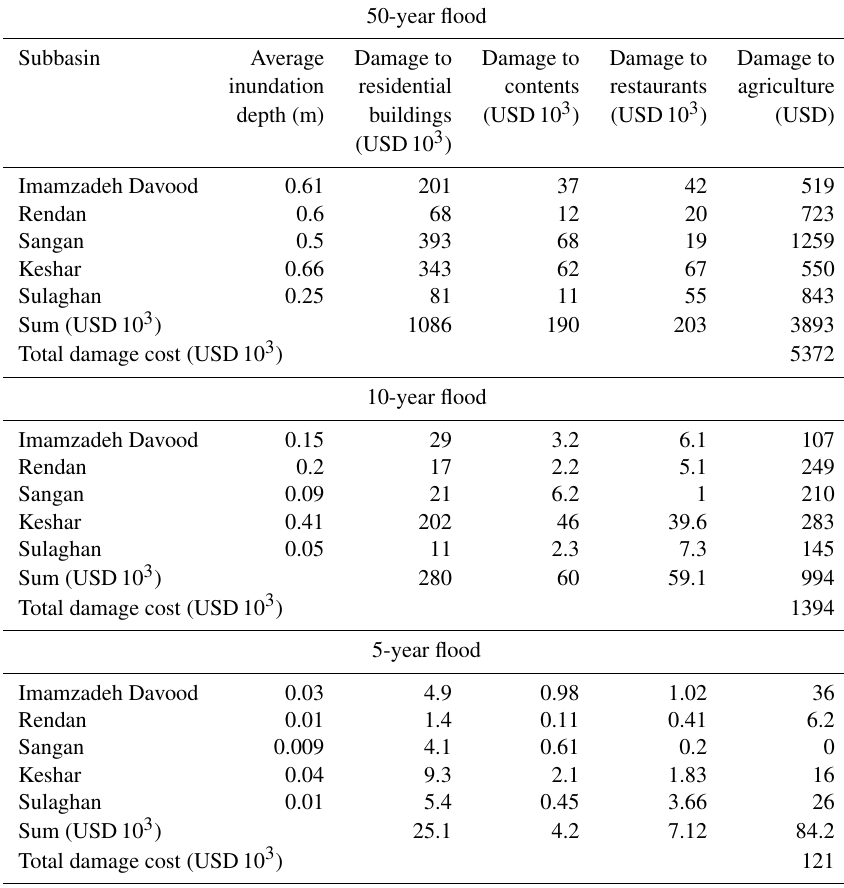
Table 3. Physical damage to the subbasin properties for floods at different return periods.